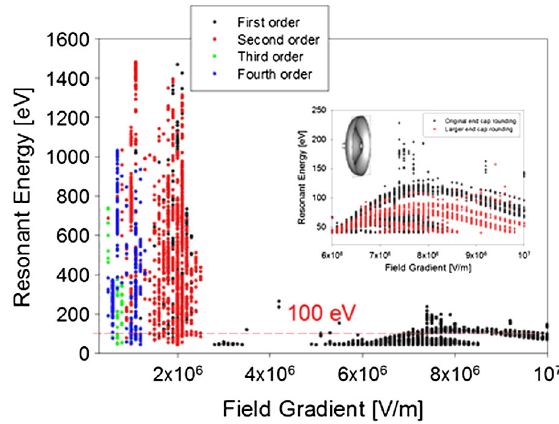
FIG. 35. Resonant electron impact energy in an end cell of the cavity in Fig. 34 for gradients up to 10 MV = m . The inset shows the impact energies for stable multipacting electrons for two different end-cap outer rounding radii.